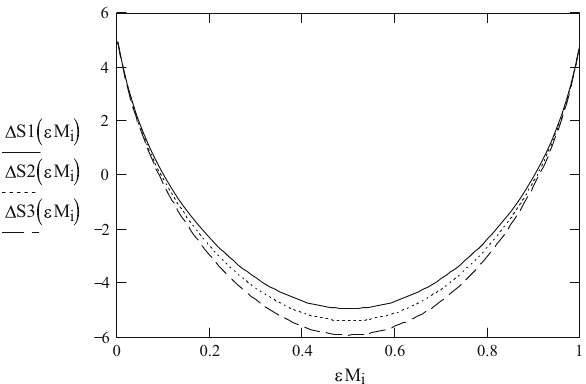
Fig. 3 The solid, dotted, dashed curves of the dependence of entropy difference (cid:4) S (cid:7) on ε M in units of π( GM ) 2 for ψ 0 = 0 . 03 , 0 . 02 , 0 . 01, respectively, with (β l p ) 2 = 5 and α l p = 1 for simplicity